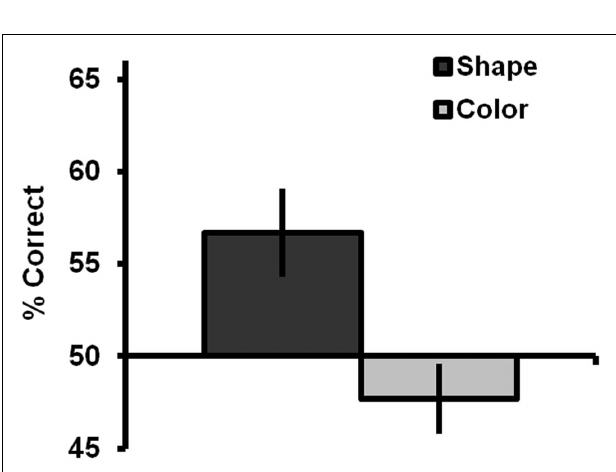
FIGURE 6 | Correct responses (as %, ± 1 SEM) for trials where the adapting image was transformed in shape only (experiment 2A) or the adapting image was transformed in color only (experiment